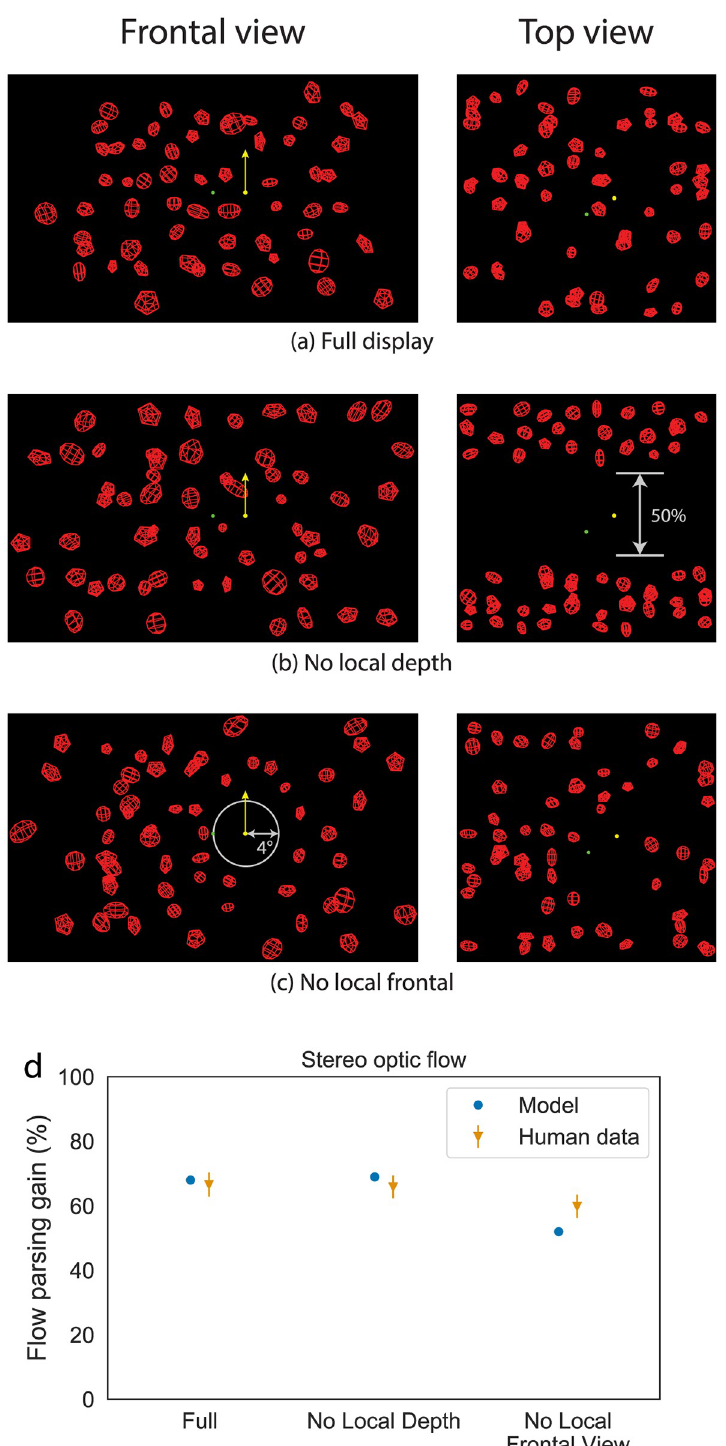
Fig 10. (a) Full, (b) No Local Depth, and (c) No Local Frontal View conditions (Simulation 3). Reproduced from Niehorster & Li [2]. (d) The flow parsing gain achieved for these conditions by the model and the human observers. Error bars denote